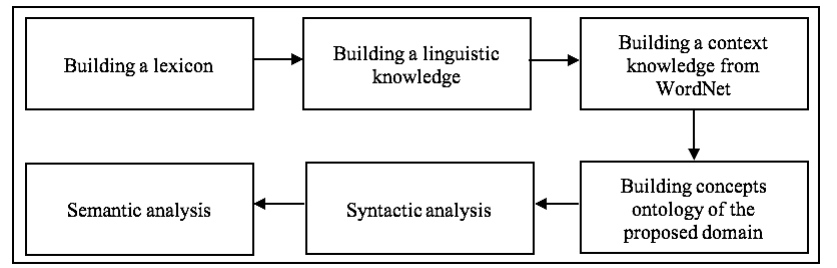
Figure 2. Methodology pipeline of the knowledge-based sense disambiguation